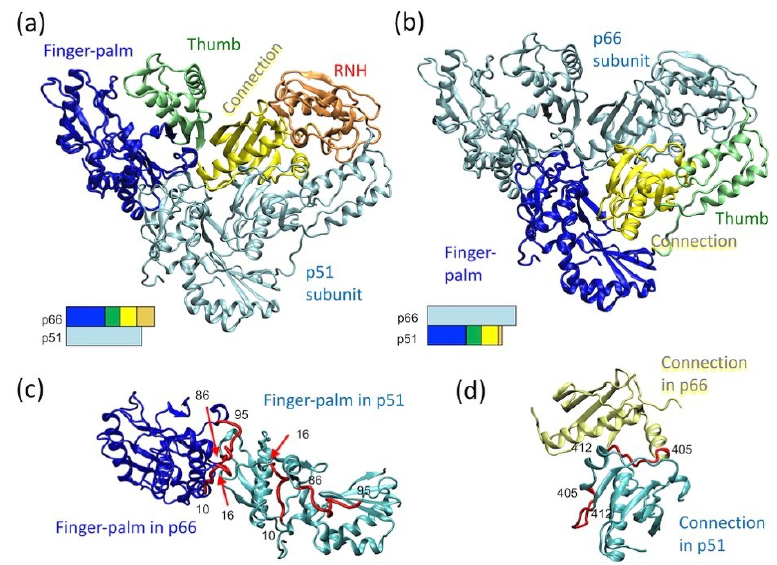
Figure 1. p66 / p51 reverse transcriptase (RT) structure, highlighting ( a ) the domain orientation in the p66 subunit, ( b ) the domain orientation in the p51 subunit, and relative orientation of ( c ) two finger–palm domains in the p66 and p51 subunits and that of ( d ) the two connection domains in the p66 and p51 subunits. In panels ( a , b ), the bar presentations below the structures indicate which domains are highlighted: finger–palm (blue), thumb (green), connection (yellow) and ribonuclease H (RNH) (orange). In panel ( c ), residues, 10–16 and 86–95, that are at the subunit interface in the p66 subunit, are highlighted with a red color in both subunits. Similarly, in panel ( d ), residues, 405–412, that are at the subunit interface in the p66 subunit, are highlighted in both subunits. The graphic presentation was made using VMD software [65] and the RT structure (PDB 1DLO [66]).